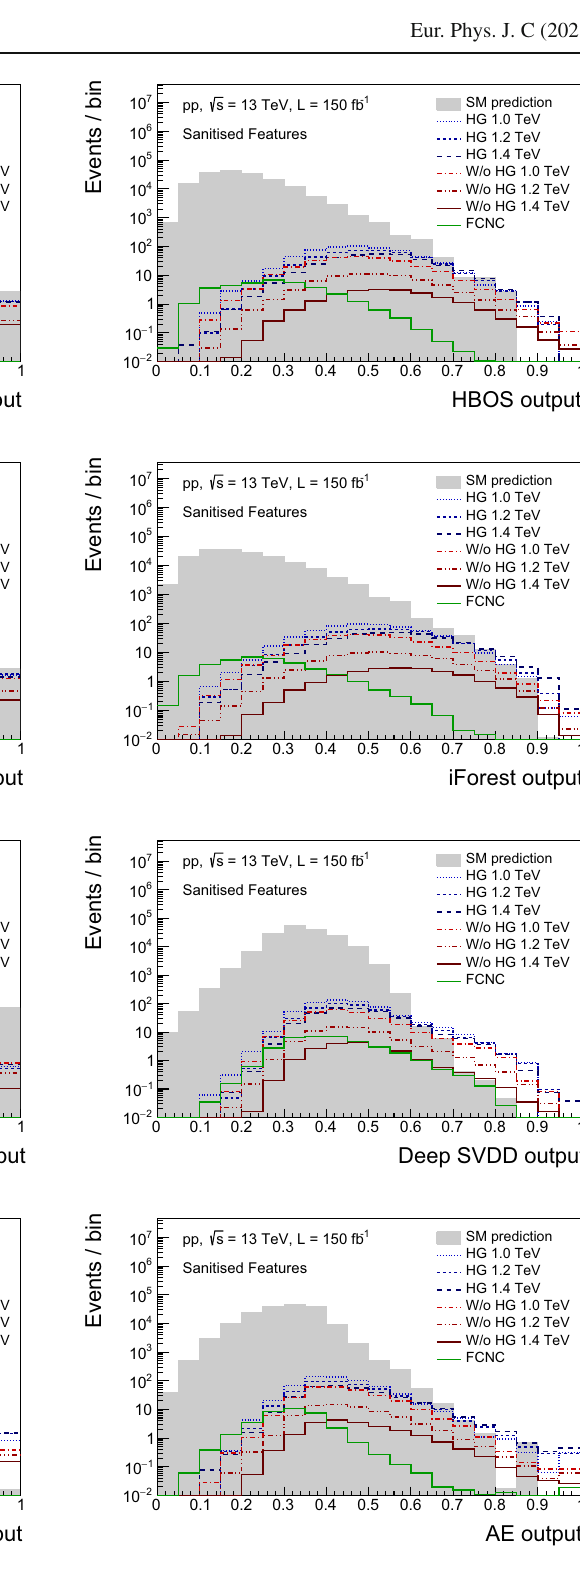
Fig. 1 Distribution of the AD discriminant for the SM prediction and each signal type: tZ production by FCNC, T ¯ T production via heavy gluon or without heavy gluon for m T = { 1 . 0 , 1 . 2 , 1 . 4 } TeV. The dis-